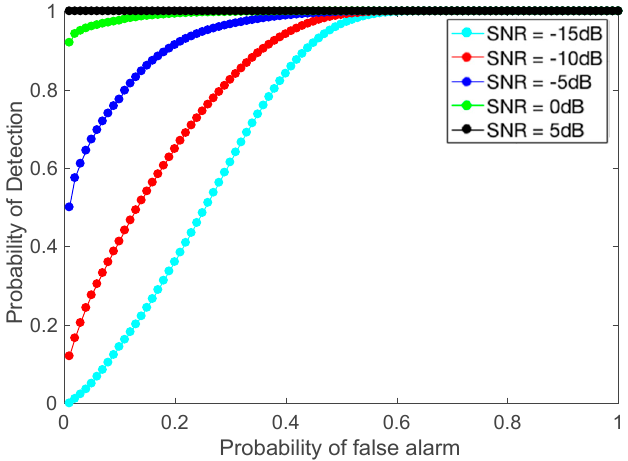
Figure 6. Probability of detection as a function of the probability of false alarm for (cid:1856) (cid:2900)(cid:2905)_(cid:2900)(cid:2905)(cid:2889) = 30 m .